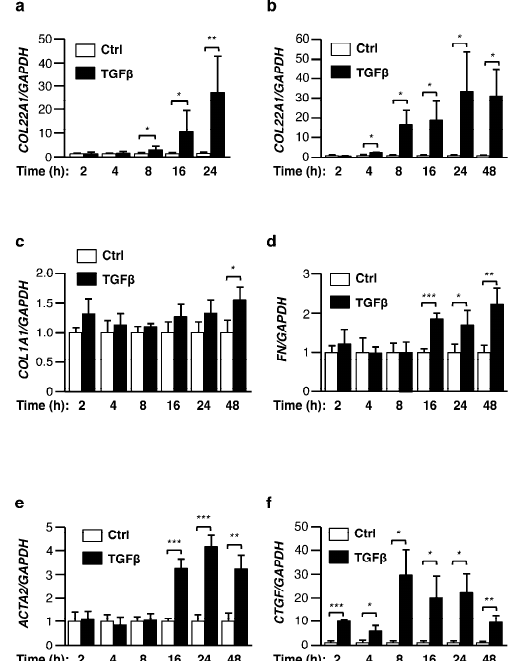
Figure 2. COL22A1 is an early response gene ex vivo and in vitro. Human skin and fibroblasts treated with TGF β (5 or 10 ng/mL) were harvested at the indicated time points. ( a ) The expression levels of COL22A1 mRNA were measured in normal human skin in organ culture (N = 5); * p < 0.05; ** p < 0.01. ( b ) Expression levels of COL22A1 mRNA were measured in primary human skin fibroblasts (N = 3): * p < 0.05. ( c ) COL1A1 mRNA levels; * p < 0.05. ( d ) FN mRNA levels; * p < 0.05; ** p < 0.01; *** p < 0.001. ( e ) ACTA2 mRNA levels: ** p < 0.01; *** p < 0.001. ( f ) CTGF mRNA levels: * p < 0.05; ** p < 0.01; *** p < 0.001.